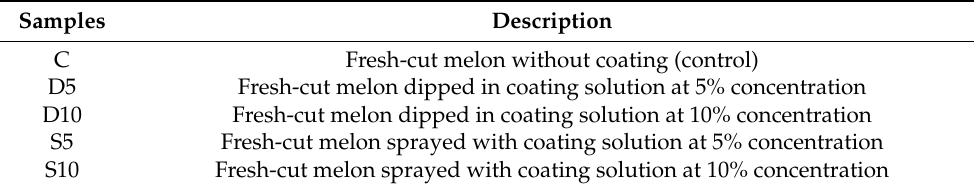
Table 1. Melon samples and their